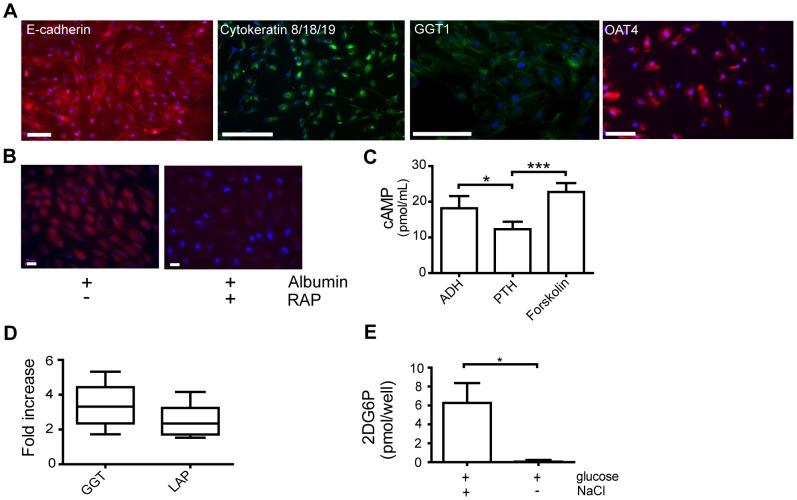
Human renal proximal tubule cells maintain epithelial markers and function with immortalization and 2D cell culture.(A) Expression of epithelial cell markers, E-cadherin (red) and cytokeratin 8/18/19 (green), the proximal tubule cell marker GGT1 (green), and the organic anion transporter OAT4 (red) in NKi-2 cells. Nuclei are stained with dapi (blue). Scale bars  =  100 µm. (B) Adenylate cyclase activity in NKi-2 cells upon treatment with ADH or PTH. Treatment with forskolin acted as a control for production of cAMP. *p<0.05, ***p<0.0001, n  =  8. (C) GGT and LAP hydrolase activity in NKi-2 cells. Fold increase is calculated against human fibroblast activity. n  =  48. (D) Na+ dependent glucose uptake in NKi-2 cells. Cells were exposed to 2-DG with or without Na+ in the form of NaCl. *p<0.05, n  =  5.